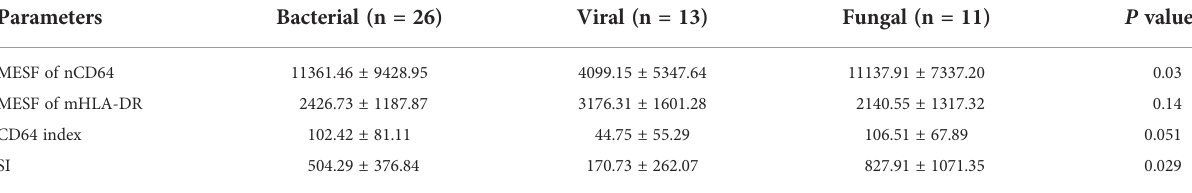
TABLE 3 The expressions of nCD64 and mHLA-DR of infection KTRs with different pathogens. Parameters